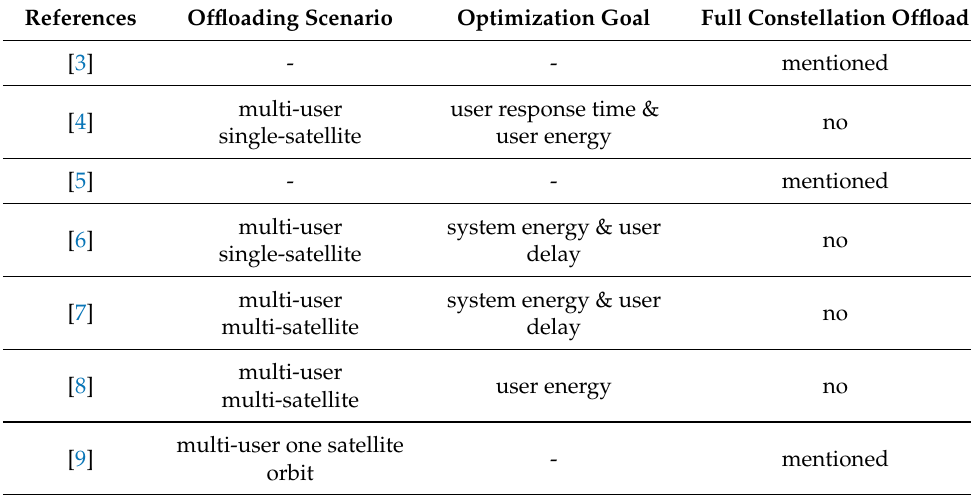
Table 1. Summary of